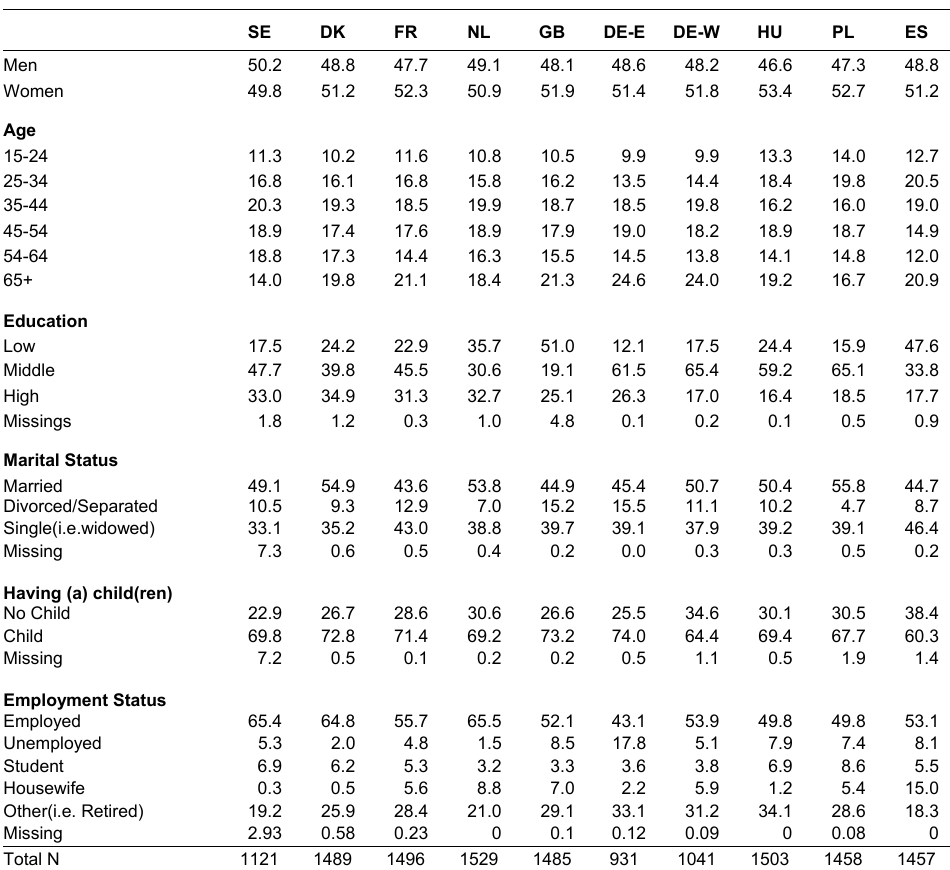
Table 5 : Summary statistics EVS 2008-2009